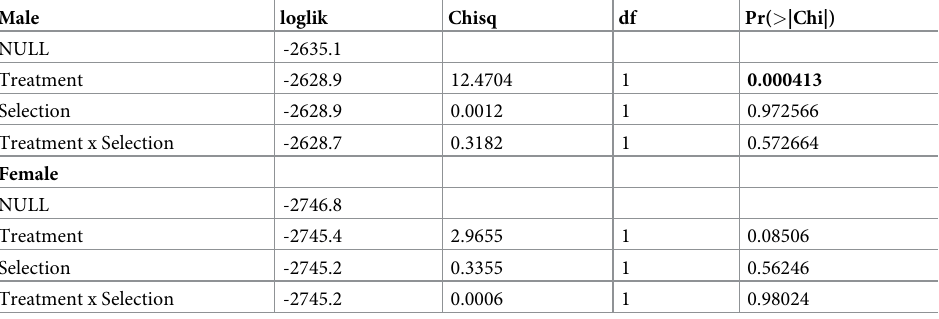
Table 2. Summary table of Cox proportional hazards analysis showing effect of selection, density treatment, and their interaction against Enterococcus faecalis . Male loglik Chisq df Pr( > |Chi|) NULL -2635.1 Treatment -2628.9 12.4704 1 0.000413 Selection -2628.9 0.0012 1 Treatment x Selection Female NULL Treatment -2745.4 2.9655 1 0.08506 Selection -2745.2 0.3355 1 0.56246 Treatment x Selection -2745.2 0.0006 1 0.98024 Significant terms are marked in